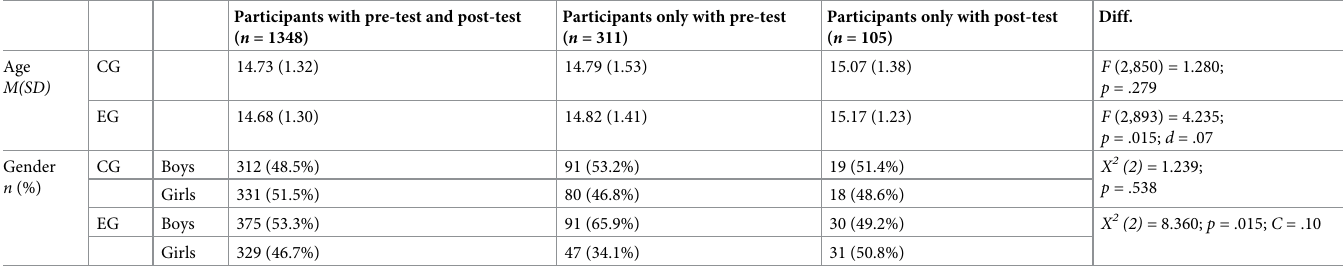
Table 2. Analysis of descriptive variables in relation with attrition and experimental